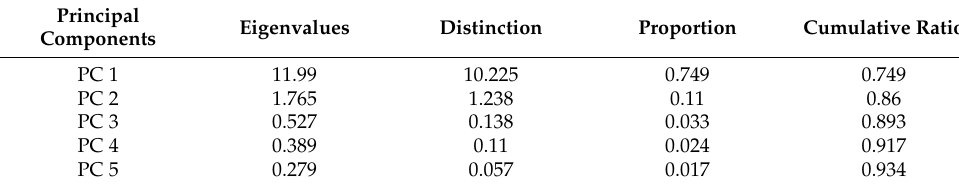
Table A2. Construction of principal components.